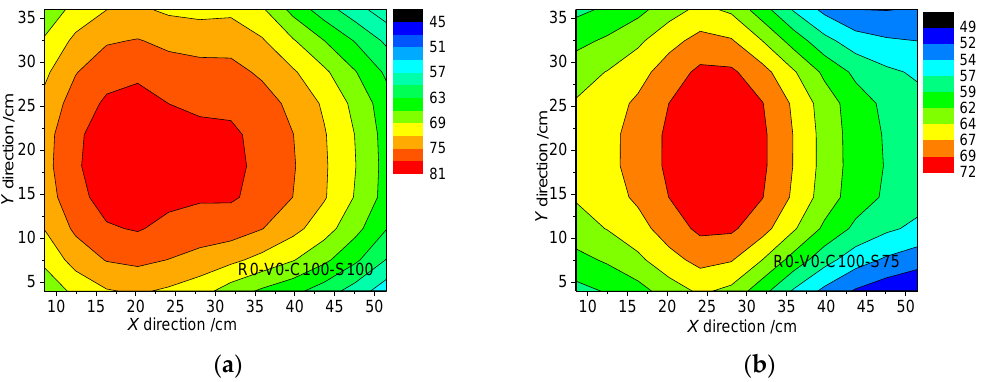
Figure 14. Variations in the shear band and apparent soil characteristics along the shearing direction .